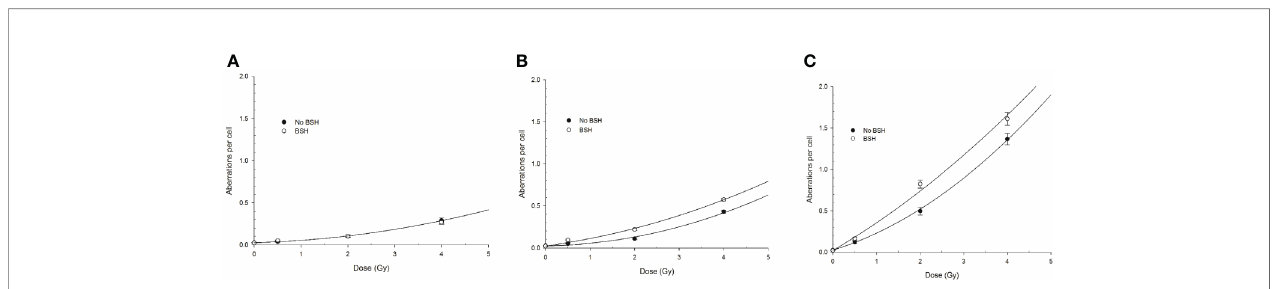
FIGURE 3 | Chromosome aberration frequency measured by WCP analysis in cells exposed along the INFN-LNS proton beam SOBP in the presence or the absence of BSH: left panel (A) refers to the entrance position, central panel (B) to mid-SOBP data from Cirrone et al. (14), and right panel (C) to distal position. Error bars depict SE of at least three independent replicates. Data were fi tted to a linear-quadratic function Y=Y 0 + a D+ b D 2 with Y 0 being the CA frequency in unirradiated